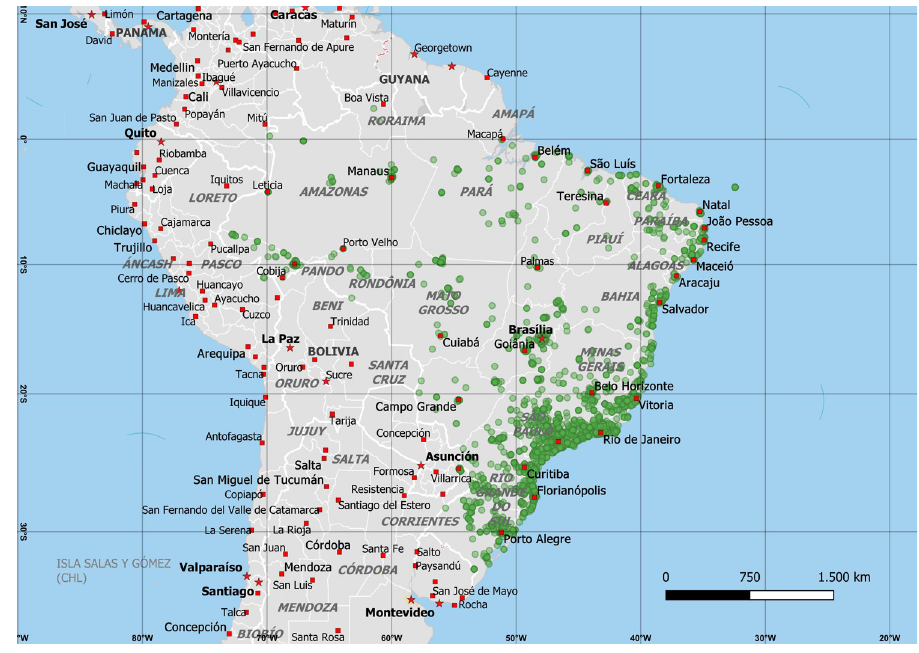
Fig 2. Geographical distribution of the observations of Eupulmonata on iNaturalist in Brazil. Eupulmonata is used as an example since it’s the gastropod taxon with the largest number of observations. In general, observations are mostly concentrated around large metropolitan areas. The map was created with QGIS software (https://QGIS.org) using map data from Natural Earth (https://naturalearthdata.com) and observation coordinates from iNaturalist.